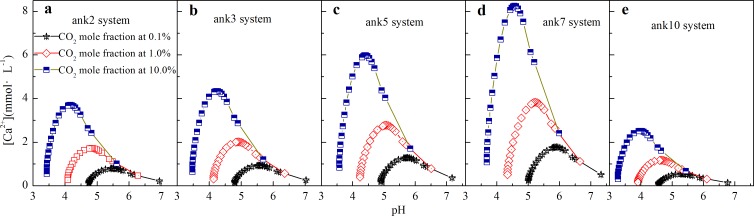
The relationship between pH and [Ca2+] in ankerite-H2O-CO2 system.